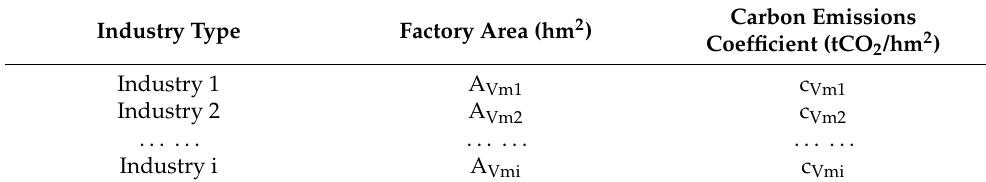
Table 3. Example of industrial land planning and associated carbon emissions